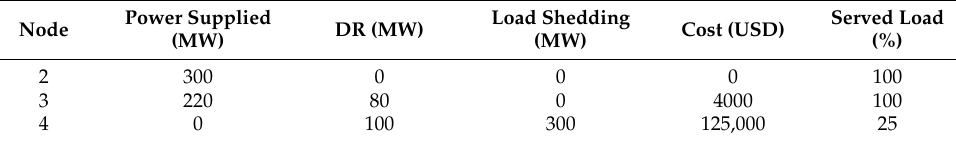
Table 8. Power dispatched and served load.